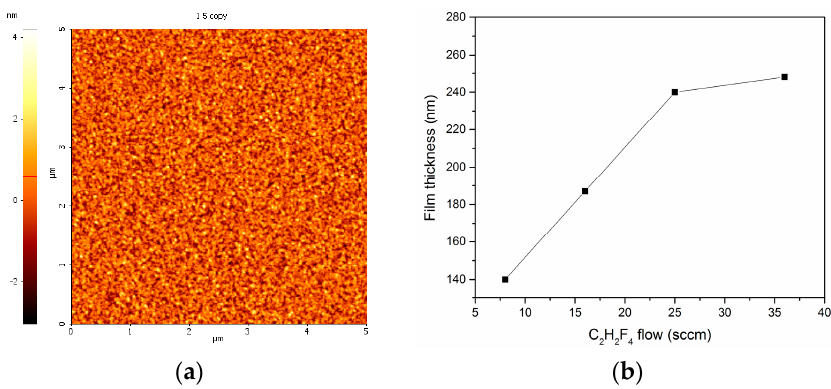
Figure 7. ( a ) Typical topography of fluorocarbon film deposited on flat Si substrate by plasma assisted